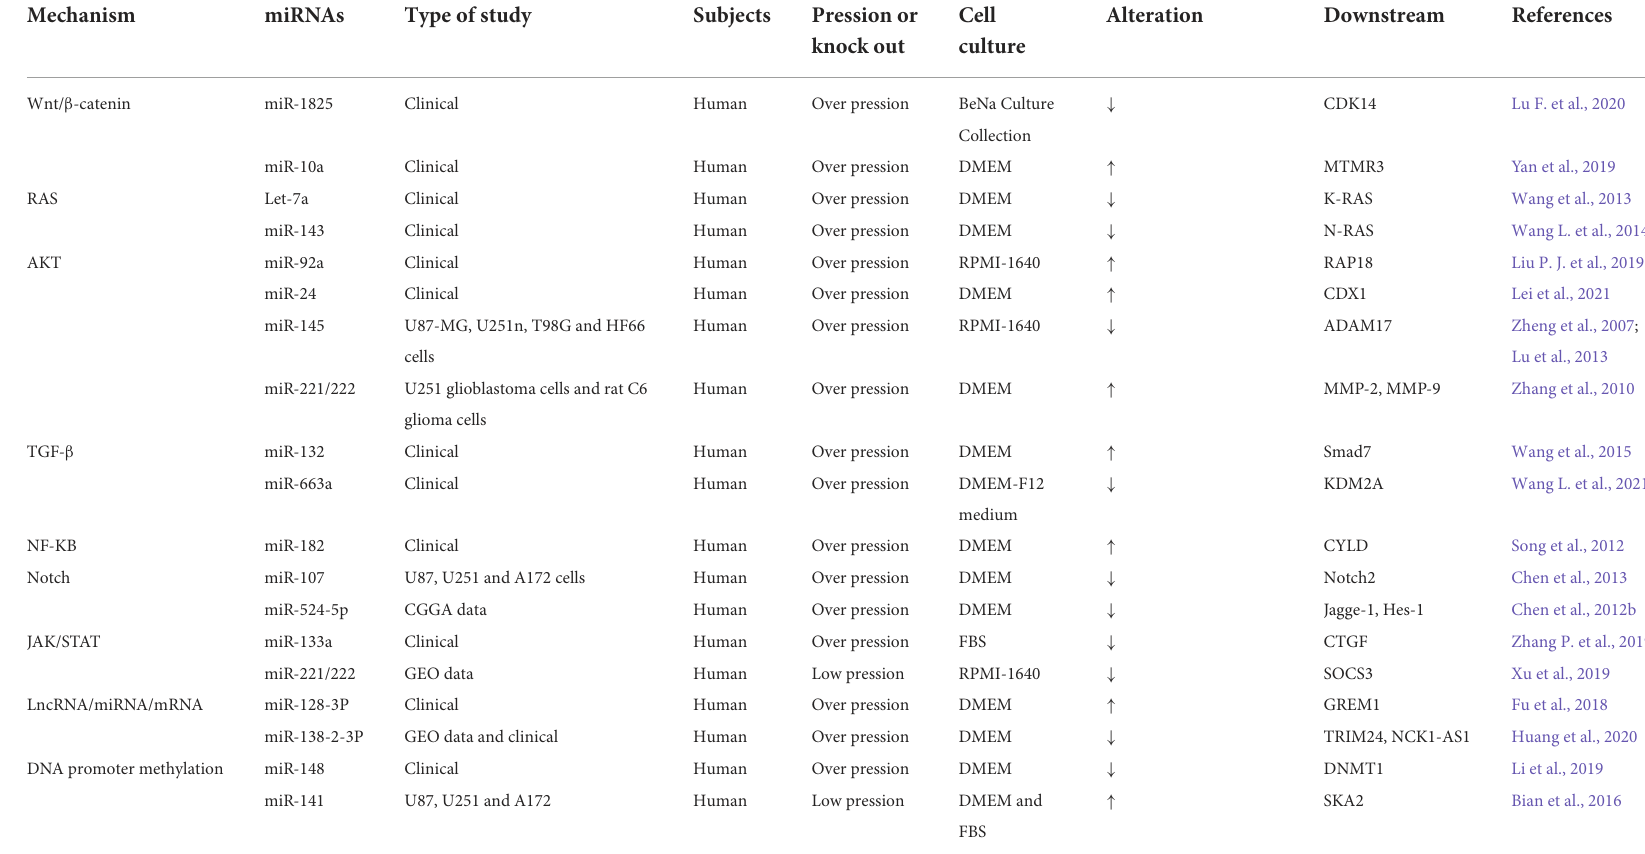
TABLE 2 The miRNA-related molecular mechanisms of glioma invasion and migration.